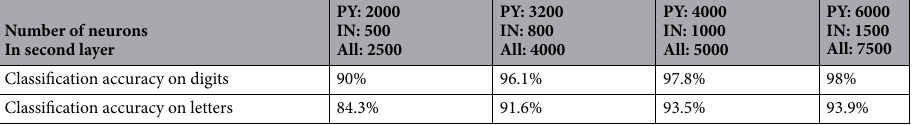
Accuracy on ORL